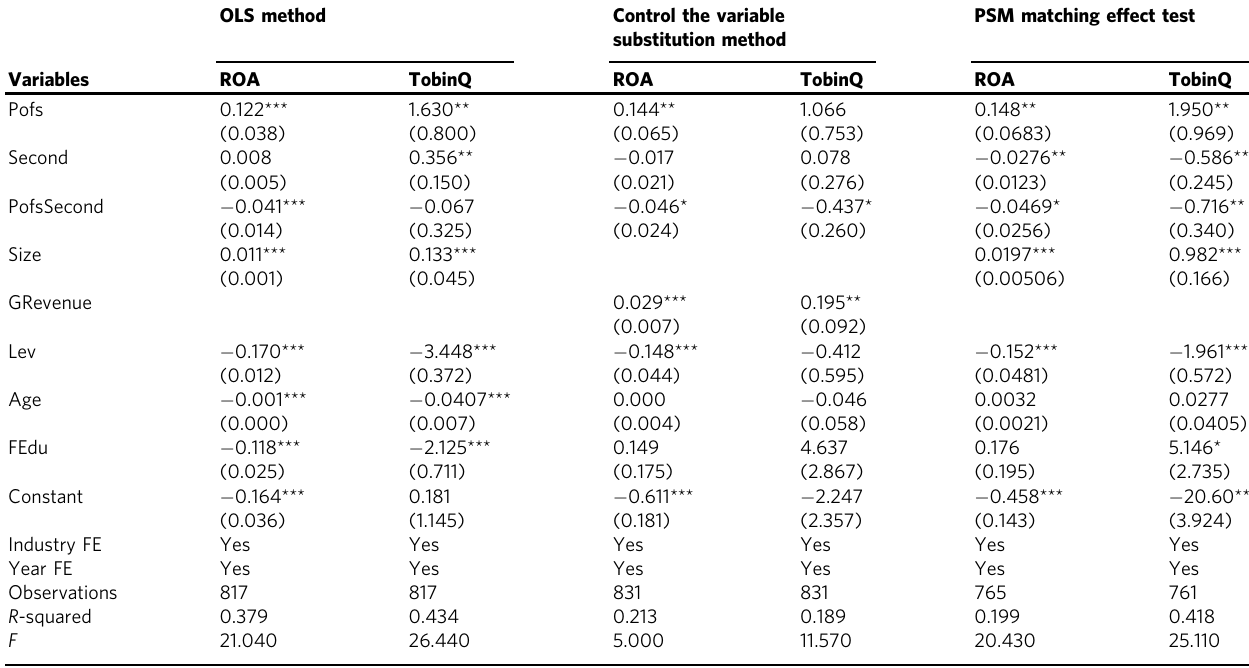
Table 11 Robustness test of female employment and fi rm performance.